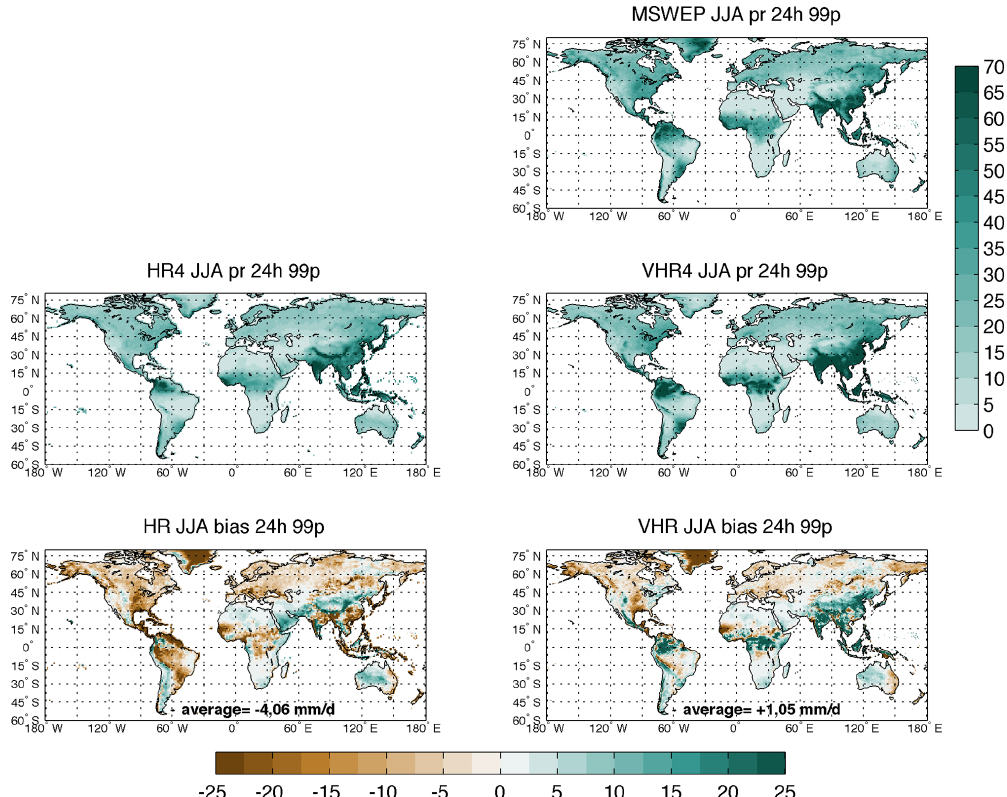
Figure 6. Summer (JJA) extreme precipitation (99th percentile, 99p) computed at the daily frequency. Upper panel shows MSWEP observa- tional results. Central panels show model results (HR on the left and VHR on the right) and lower panels show the relative model bias. Units are [mmd − 1 ]. Vertical color bar refers to the three upper panels, while the horizontal color bar refers to the two bottom